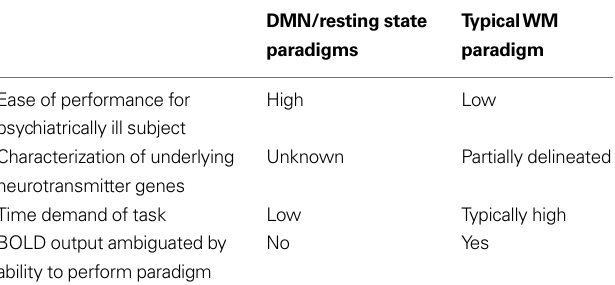
Table 3 | Comparison of default mode versus “dominant” working memory functional